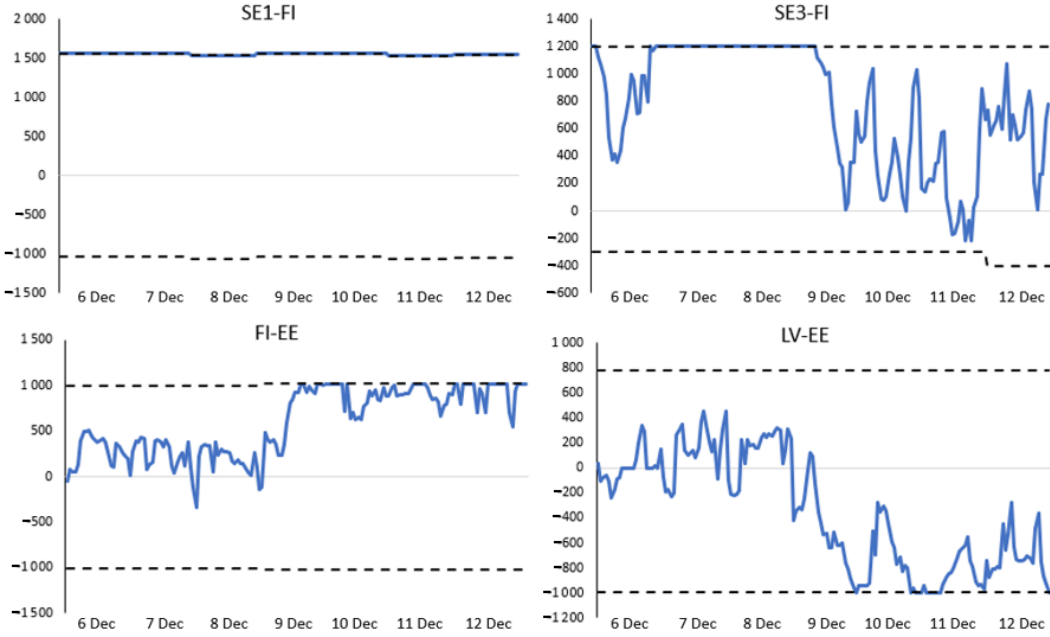
Figure 6. Hourly scheduled commercial flows for Finland and Estonia during 6–12 December.